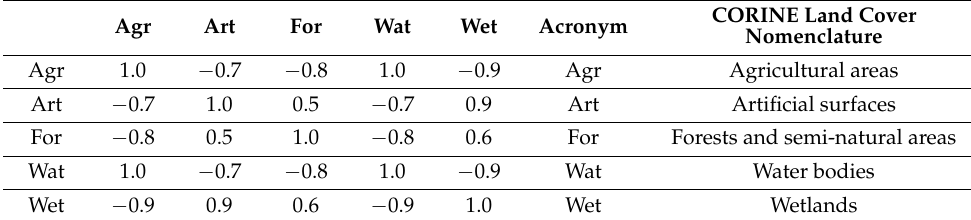
Table 10. Spearman’s rank correlation coefficient in the Canary